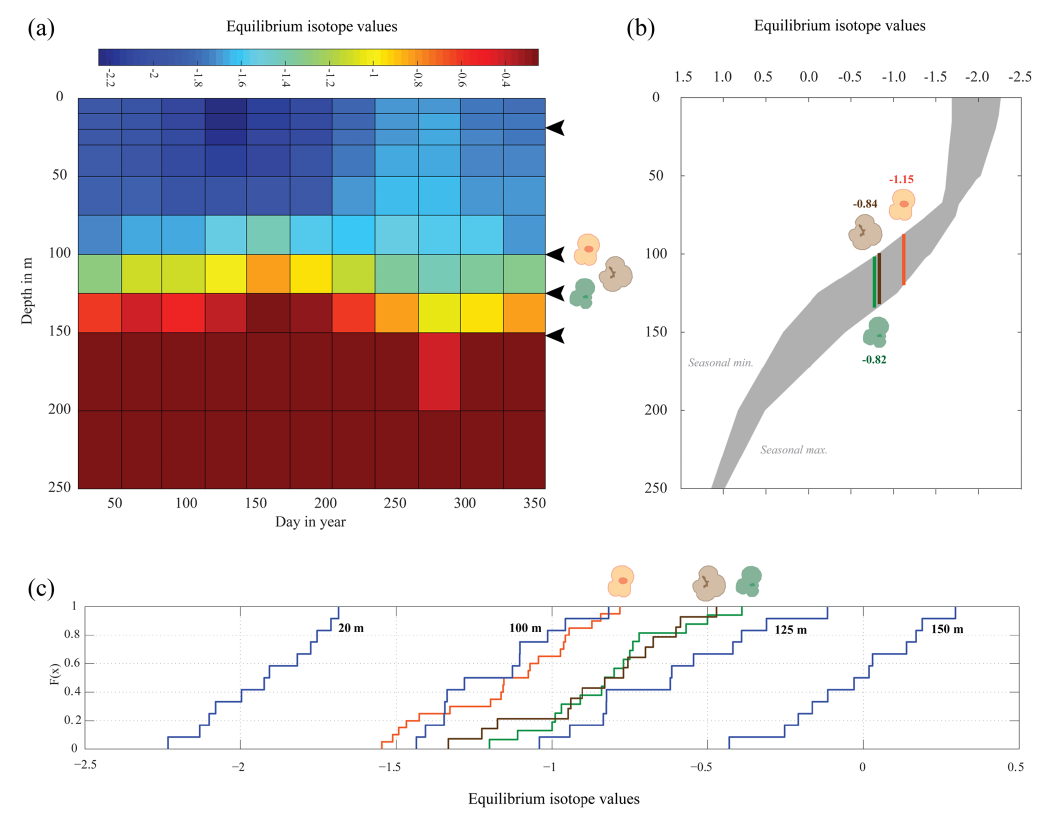
Figure 7. Season or depth, predicting likely depth habitats of planktonic foraminiferal species using inferred equilibrium oxygen isotope values ( δ 18 O eq ). World Ocean Atlas (WOA13) temperature and salinity were used to compute the equilibrium oxygen isotope value using the tropical Atlantic δ 18 O–salinity relationship defined by LeGrande and Schmidt (2006) input into a rearranged form of Kim and O’Neil (1997) (see Sect. 2.4). (a) Contour plot of δ 18 O eq , plotted as depth in metres vs. day in year. Note the uneven depth interval distribution inherent within the WOA dataset. Black arrows represent depths chosen in (c) to calculate cumulative distribution, species symbols represent inferred depths of mean average values. (b) The seasonal minimum and maximum (grey band) in δ 18 O eq for each depth interval, coloured bars represent depth intervals that are similar to isotopic values of the three species. (c) Cumulative density distribution of the three species plotted alongside the CDF for 20, 100, 125 and 150m distributions; values are plotted as probability ( F(x) ) vs. oxygen isotope value. All values plotted in per mil (‰) on the V-PDB